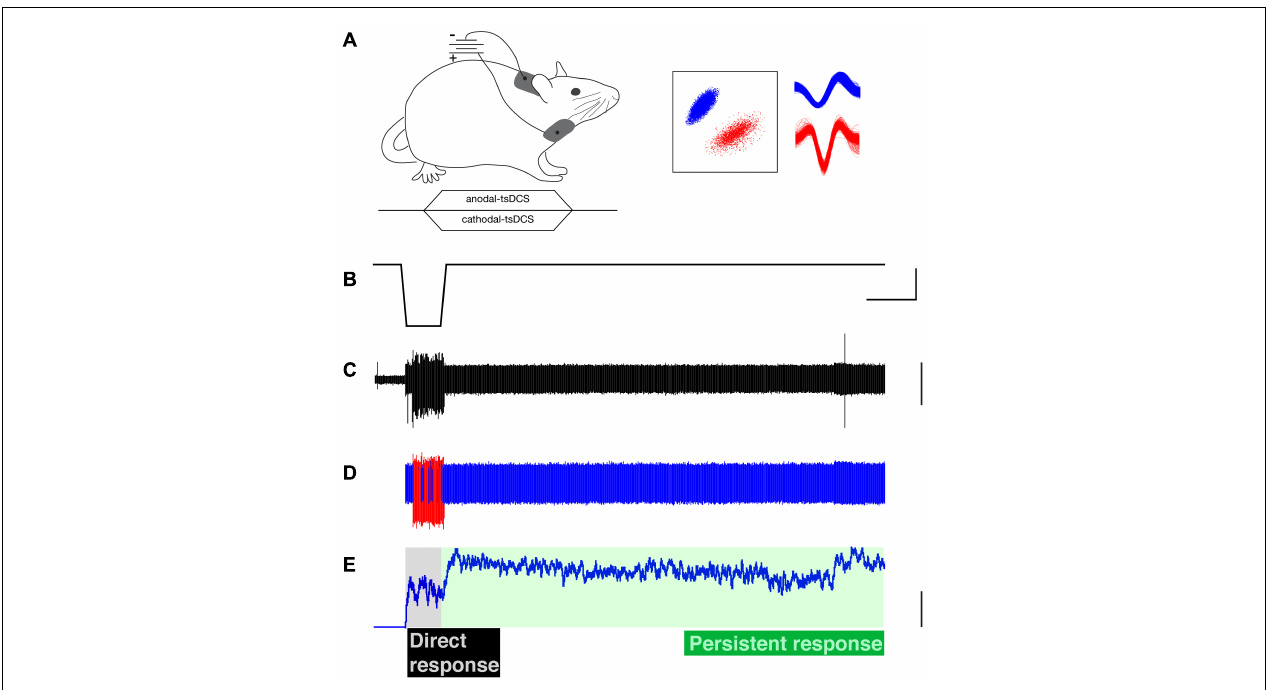
FIGURE 1 | Trans-spinal direct current stimulation (tsDCS) and single motor unit recording. (A) Schematic of experimental setup (top) and time-course of tsDCS (bottom). tsDCS was delivered through patch electrodes with the active electrode placed dorsally over the C4 to T1 vertebrae and the return electrode (i.e., opposite polarity) placed over chest. tsDCS was ramped over a 3s period to the maximal current, which was maintained for 20s, and ramped back to zero during a 3s period. (B) Cathodal-tsDCS waveform. (C) Raw electromyographic (EMG) recording (ECR muscle). (D) Raw EMG activity was sorted into single motor units using a PCA-based identification. Representative examples of two single motor units (red and blue). Their corresponding waveforms are shown in part (A) (right). (E) The firing rate was used to characterize the firing pattern; only the firing rate of the blue-colored unit is shown. The direct response is during the stimulation period (gray shading), whereas the persistent response is after tsDCS is turned off (green shading). Calibrations. (B) 25s, 2.5 vDC. C. 0.2 arbitrary units. (E) 25